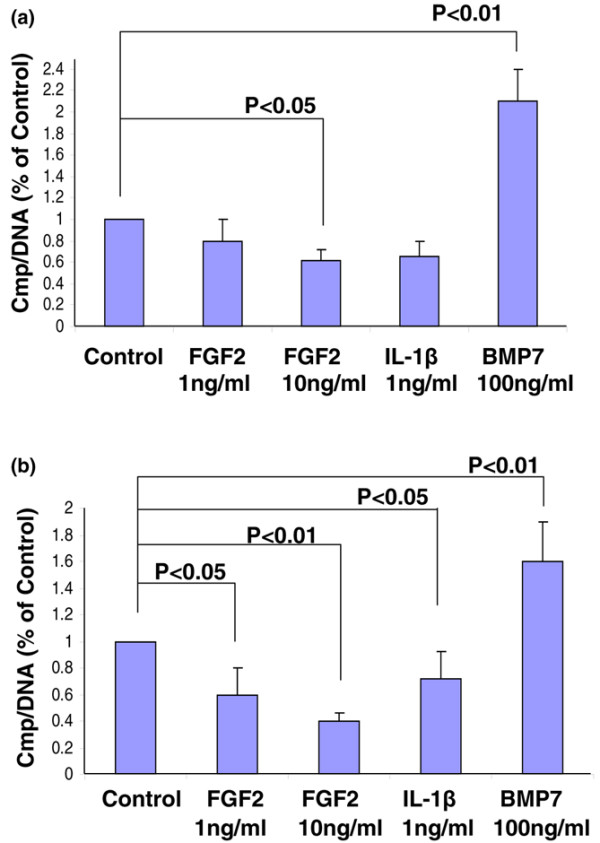
Fibroblast growth factor 2 inhibits proteoglycan synthesis in the cell-associated matrix. (a) Nucleus pulposus cells and (b) annulus fibrosus cells isolated from bovine intervertebral disc were cultured for 7 days in 1.2% alginate in serum-free medium with mini-insulin–transferrin–selenium (control) or the control medium plus 1 and 10 ng/ml fibroblast growth factor 2 (FGF2), 1 ng/ml IL-1β, or 100 ng/ml BMP7. Proteoglycan synthesis was measured during the last 4 hours of culture using [35S]-sulfate incorporation and was normalized to cell numbers by DNA assay. Data expressed as a percentage of control for triplicate samples. Error bars represent the triplicate analysis of three pooled donors.